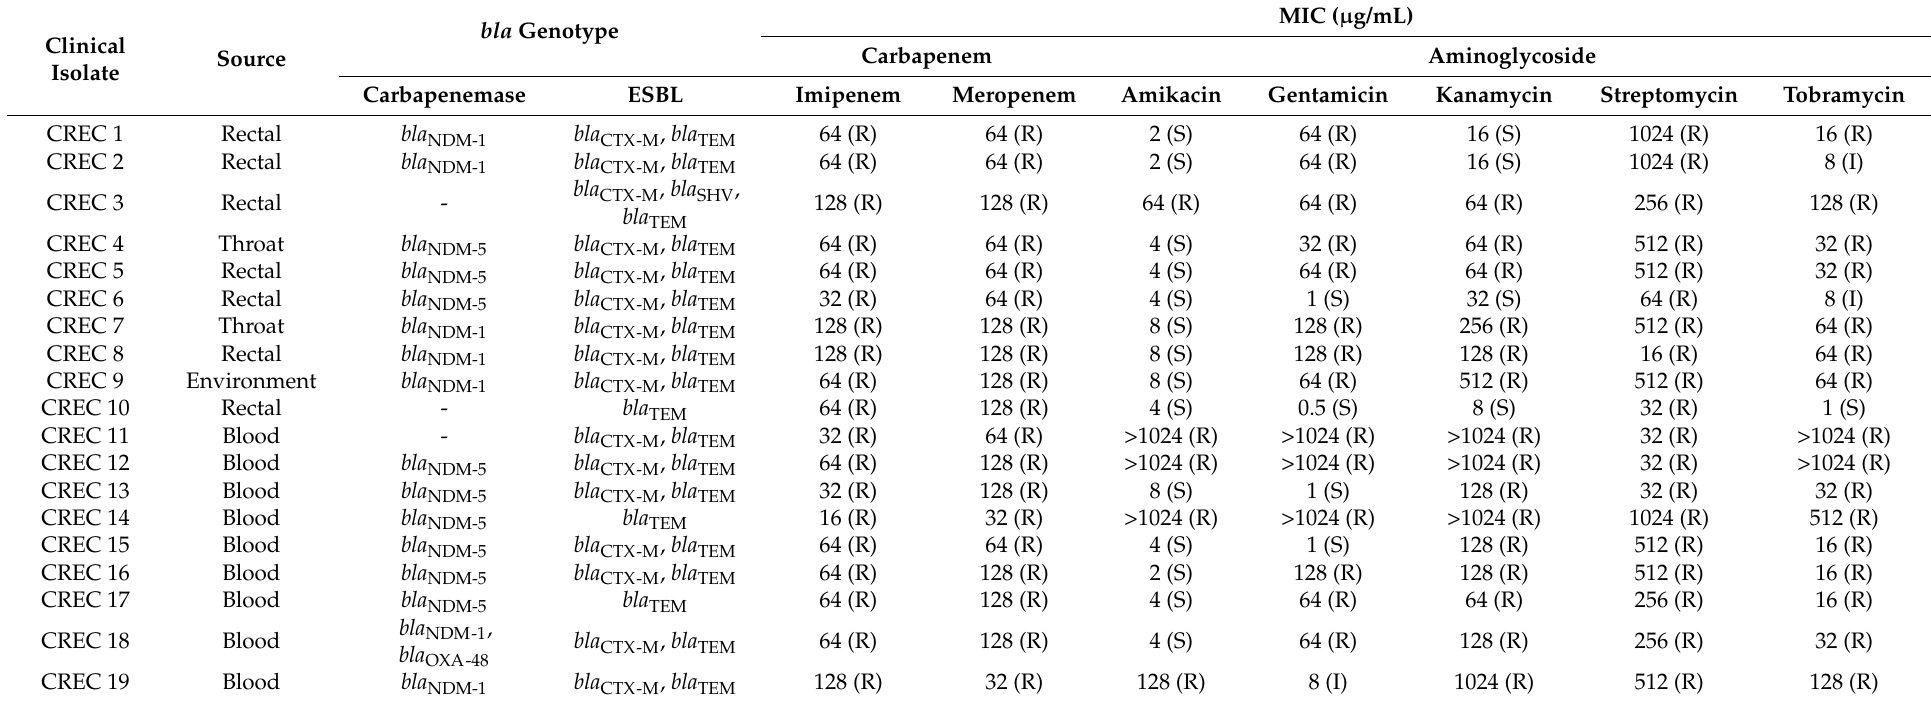
Table 2. Antibacterial profile of aminoglycoside and carbapenem resistance in 19 carbapenem-resistant Escherichia coli